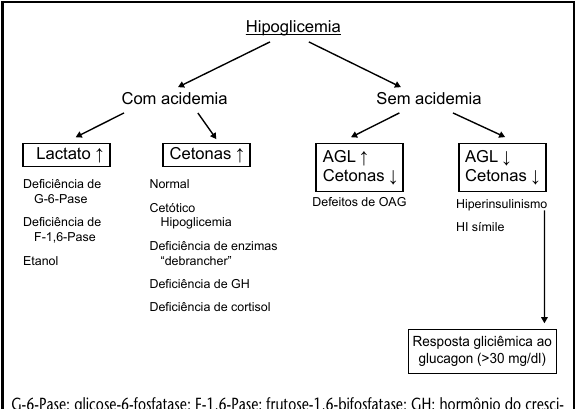
Figura 2. Resultados da amostra crítica de sangue obtida no momento da hipoglicemia servem de base para distinguir 4 categorias de doenças: comprometimento da gliconeogênese, Figura 2 – Resultados da amostra crítica de sangue obtida no momento da hipogli- cemia servem de base para distinguir quatro categorias de doença: comprometimento da gliconeogênese, formas normais e anormais de hipoglicemia cetótica, defeitos na oxidação de ácidos graxos e cetogênese e comprometimento de lipólise e cetogênese